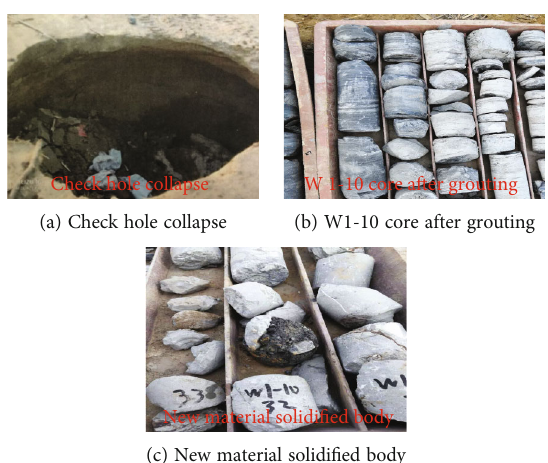
Figure 14: Drilling detection of grouting e ff ect.